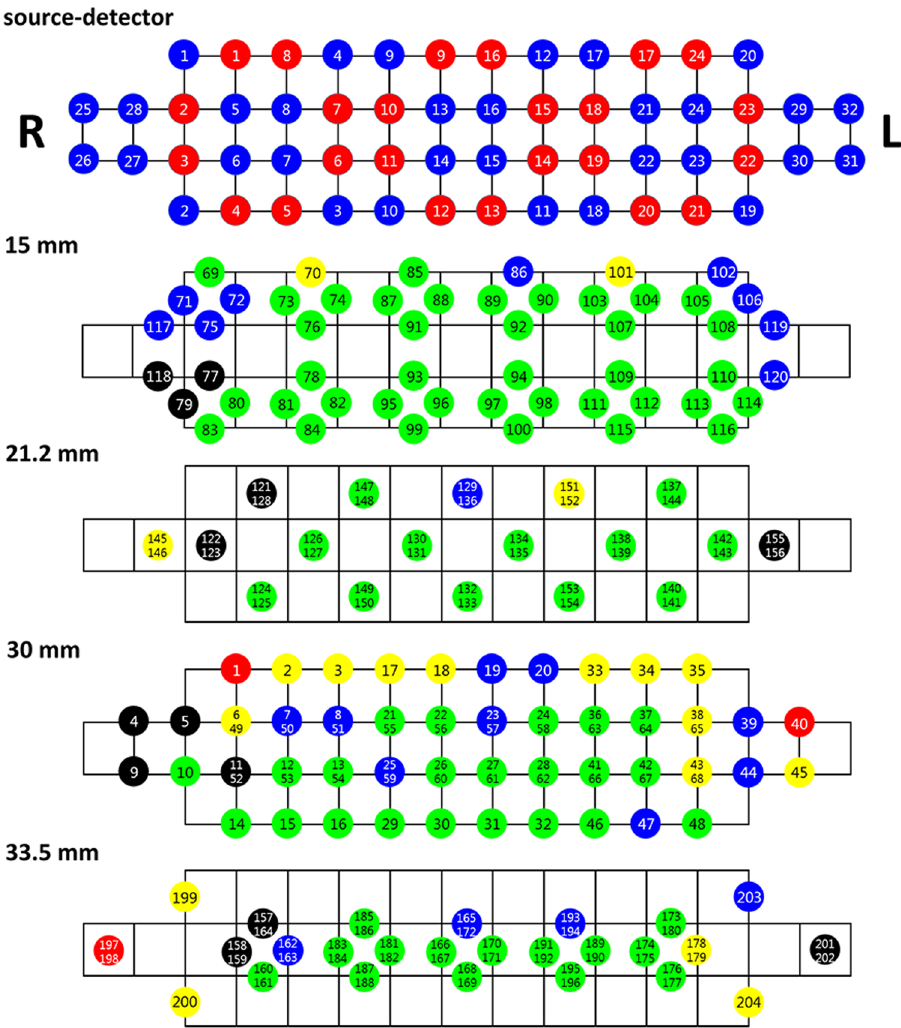
Figure 1. Arrangement of sources and detectors, and location of NIRS channels for 15, 21.2, 30, and 33.5 mm SD separations. The numbers in red and blue circles are source and detector numbers, respectively (top). For numbered NIRS channels, green, blue, yellow, red, and black colours, indicate 0, 0–10, 10–30, 30–50, and higher than 50% rejection ratios, respectively. The size of the grid is 15 × 15 mm.